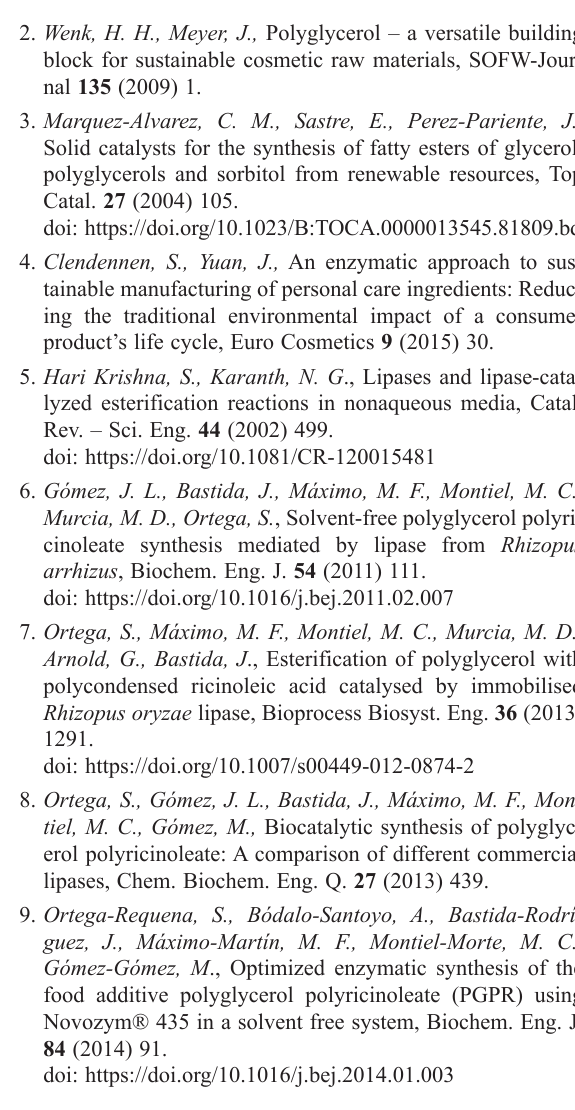
Fig. 6 – Degree of esterification of each PG-10 molecule calculated by measuring saponification and acid value. Black bars indi- cate PG-10 laurate and white bars indicate PG-10